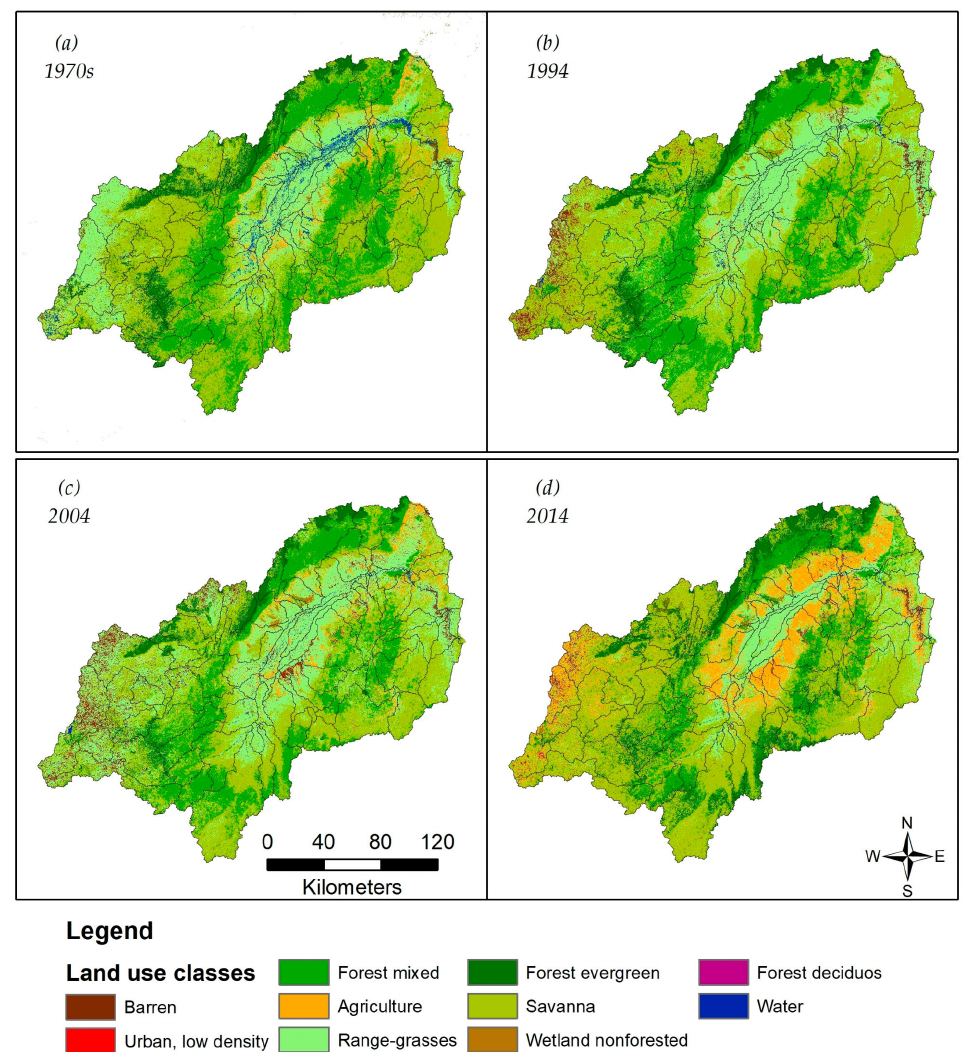
Figure 3. Land use and land cover classifications for four time steps ranging from ( a ) 1970s, ( b ) 1994 and ( c ) 2004 to ( d ) 2014 (modified after Leemhuis et al.